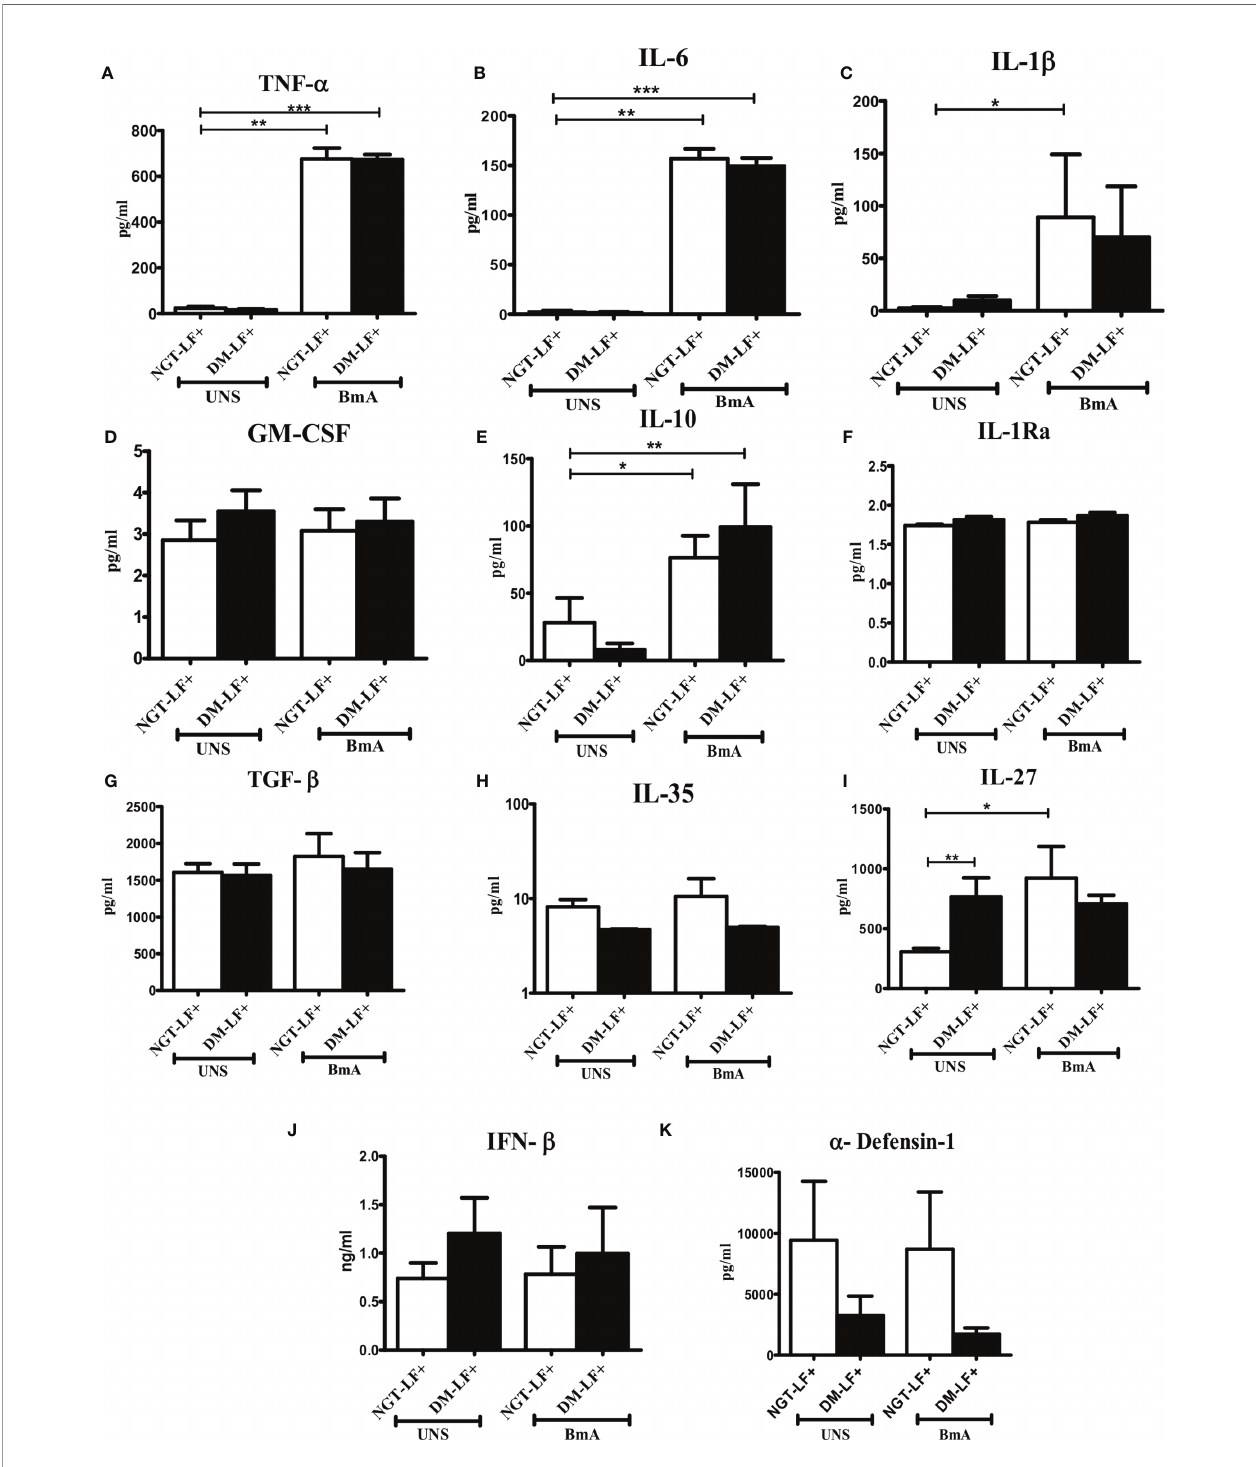
FIGURE 4 | Effect of diabetes on the antigen-induced secretion of pro- and anti-in fl ammatory cytokines, type 1 interferons, and defensins in LF+ subjects. Bar graph showing Unstimulated (UNS) and fi larial antigen (BmA)-induced secretion of TNF- a (A) , IL-6 (B) , IL-1 b (C) , GM-CSF (D) , IL-10 (E) , IL-1Ra (F) , TGF- b (G) , IL-35 (H) , IL-27 (I) , IFN- b (J) , and a -defensin (K) in the supernatants of blood cultures in NGT-LF+ and DM-LF+ subjects. Statistical signi fi cance was determined by non-parametric Mann – Whitney U test and p < 0.05 was considered signi fi cant. * p < 0.05; ** p < 0.01; *** p <